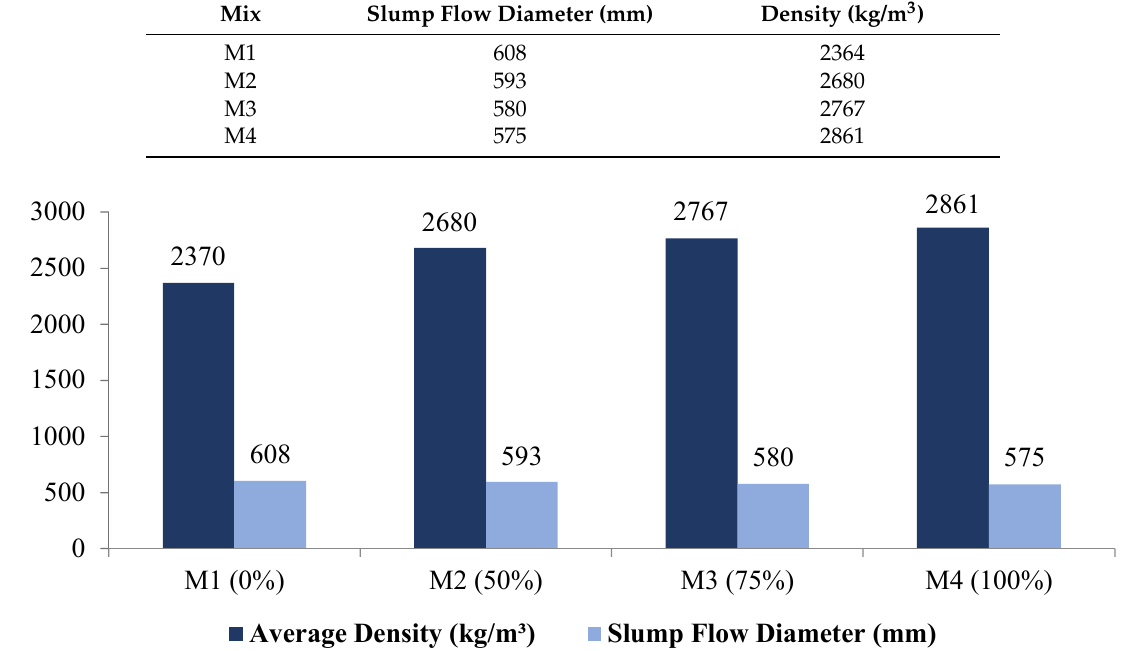
Table 8. Fresh property test results.